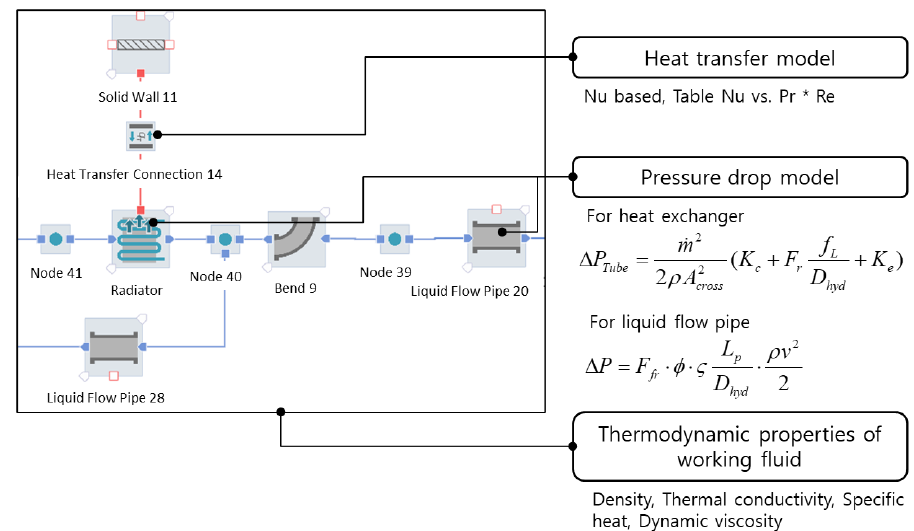
Figure 4. Heat transfer and pressure-drop model in the cooling system.